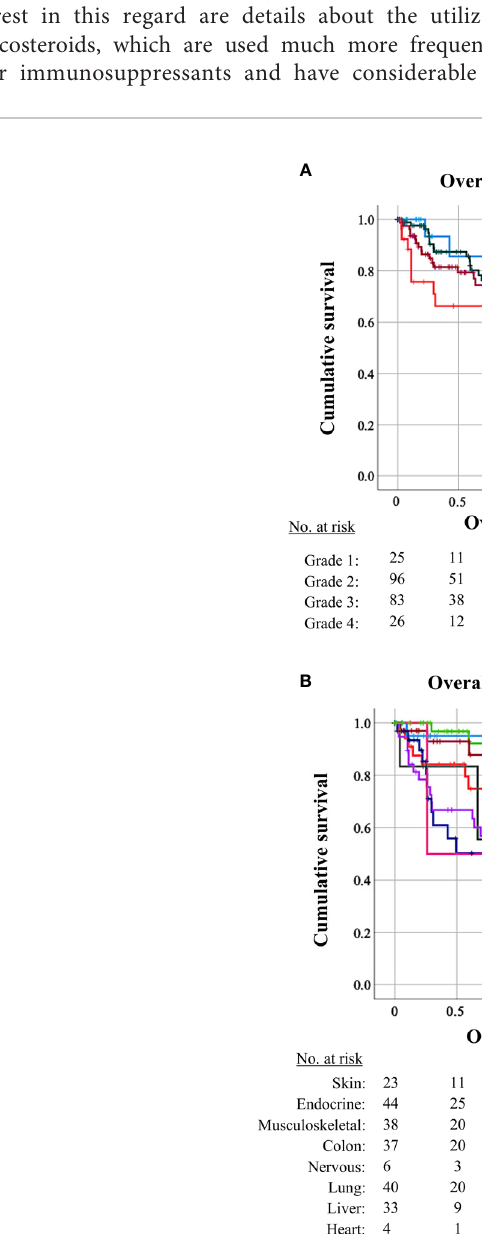
FIGURE 5 | Survival of patients with grade 1 – 4 immune-related adverse events by affected organ. (A) Overall survival (OS) from start of immunotherapy for non-small- cell lung cancer (NSCLC) patients developing immune-related adverse events (irAEs) did not differ signi fi cantly by irAE grade (logrank p = 0.71). Median OS was 29 months [95% con fi dence interval (CI) n/a] in case of grade 1 irAE, 23 months (13.0 – 31.2) in case of grade 1 irAE, 28 months (3.7 – 52.6) in case of grade 3 irAE, and 25 months (8.5 – 41.4) in case of grade 4 irAE. (B) OS for NSCLC patients developing irAE showed signi fi cant differences according to the irAE type (logrank p = 0.007). Median OS was 28.1 months (CI 23.9 – 32.3) for patients with dermatologic irAE, with 2-year OS rate 95% (CI 85 – 100); 23 months (CI n/a) for patients with endocrinologic irAE, with 2-year OS rate 47% (CI 15 – 79); not reached for patients with musculoskeletal irAE, with a 2-year OS rate 61% (36 – 85); 22 months (3.1 – 40.6) for patients with colitis, with a 2-year OS rate 44% (14 – 75); 13 months (4.2 – 21.8) for patients with pneumonitis, with a 2-year OS rate 38% (19 – 57); and 9.5 months (1.4 – 17.6) for patients with hepatitis, with a 2-year OS rate 37% (14 – 59); 9.1 months (7.3 – 10.9) with a 2-year OS rate of 27.8% (CI 0 – 73) for patients with neurological irAE; and 3.1 months (CI na) for patients with cardiologic irAE with a 2-year OS rate 0%. Only irAE with >3 occurrences in our patients were included in this